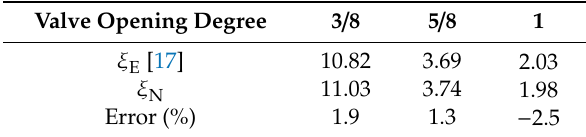
Table 2. The comparison between the numerical results and the experimental results.